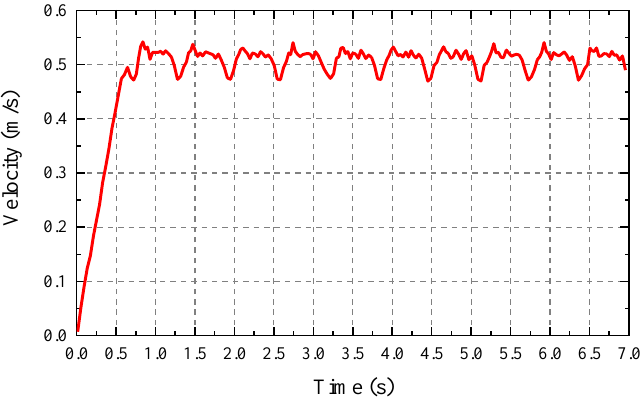
Figure 16. Forward velocity of the HHR.